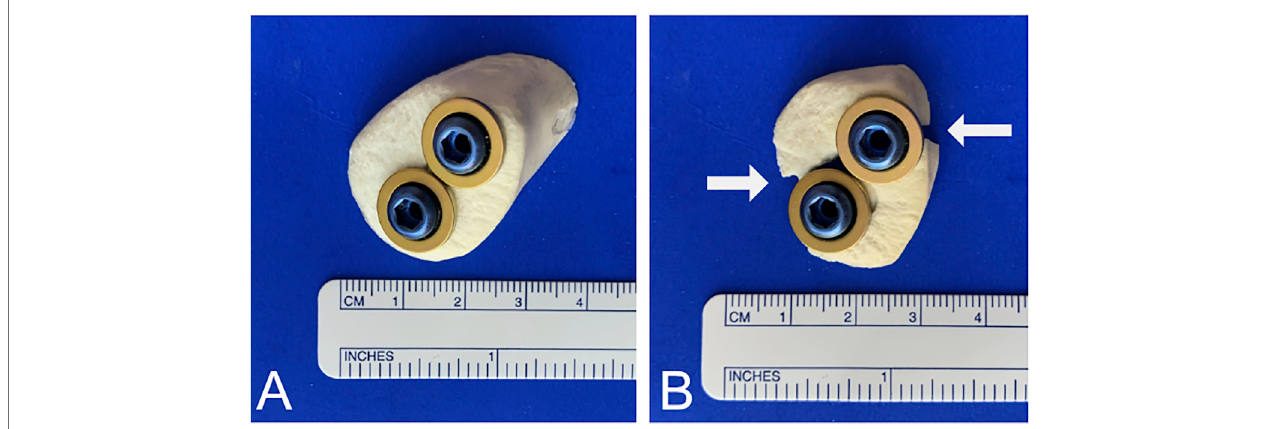
FIGURE7| Screw-to-boneratio. (A) Toavoidburstofthefracturecausedbyoversizedscrews,a1:2screw-to-boneratioisrecommended. (B) Cracksandbursts of the fracture can occur when the screw size is not appropriate. White arrows indicate fracture.